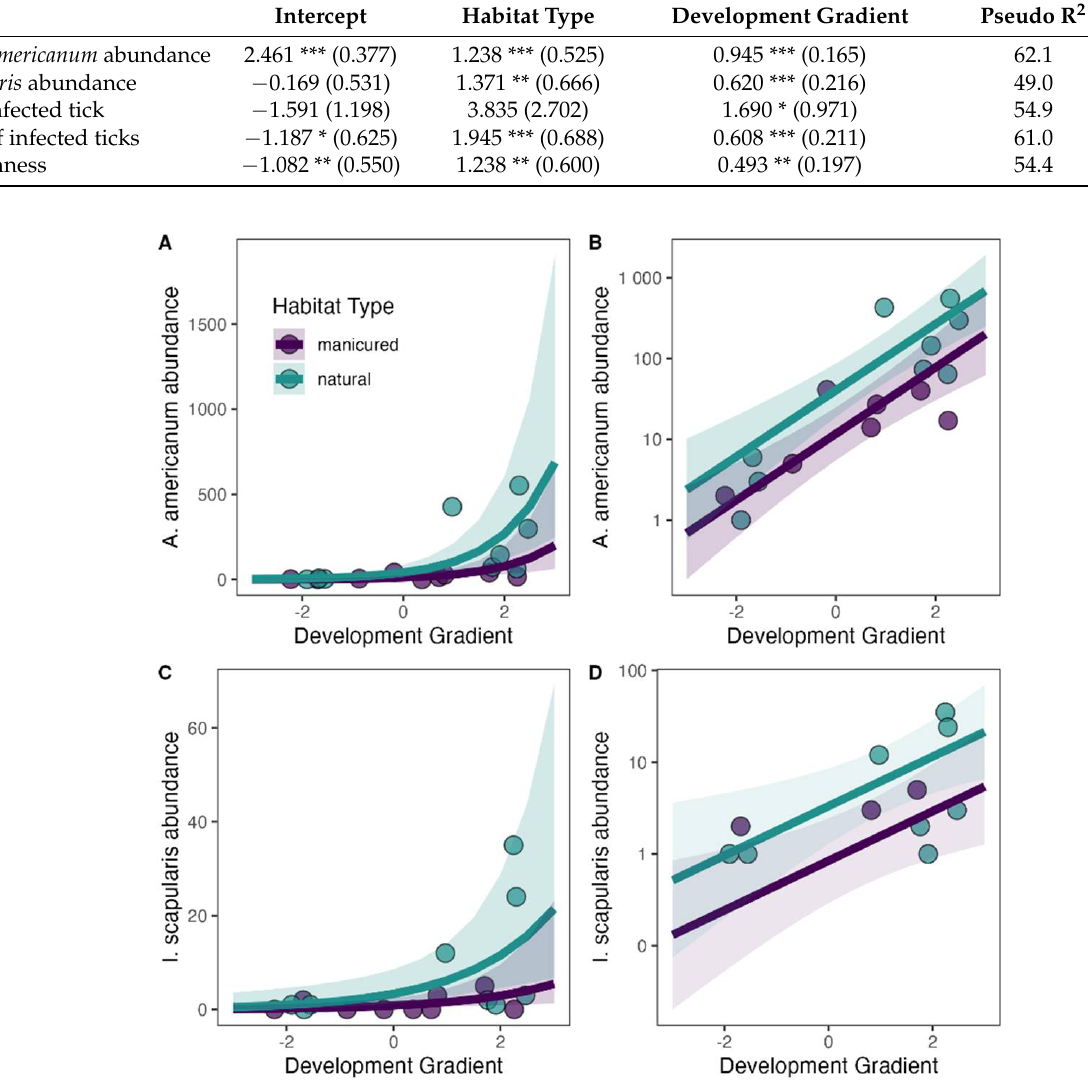
Figure 3. Model predictions for the influence of the development gradient (developed to undevel- oped) and habitat type (green = natural; purple = manicured) on raw ( A , C ) or log-transformed ( B , D ) tick abundance for Amblyomma americanum adults and nymphs combined ( A , B ), and Ixodes scapularis adults ( C , D ) in greenspaces in Alachua County, Florida, USA. Lines indicate model prediction and grey regions represent the 95% CI of the prediction .